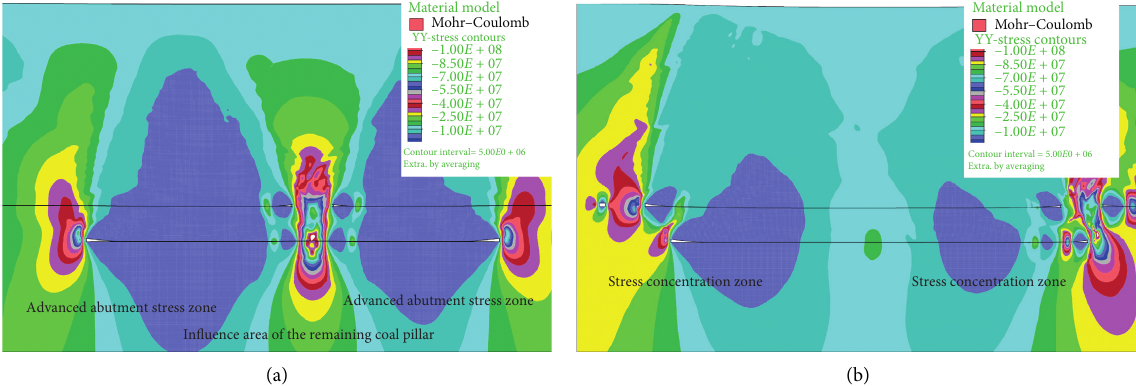
Figure 7: Distribution of the stress-concentration zones in the working face during mining under different horizontal distances L . (a) L � 160m (three stress-concentration zones). (b) L � 20m (two stress-concentration